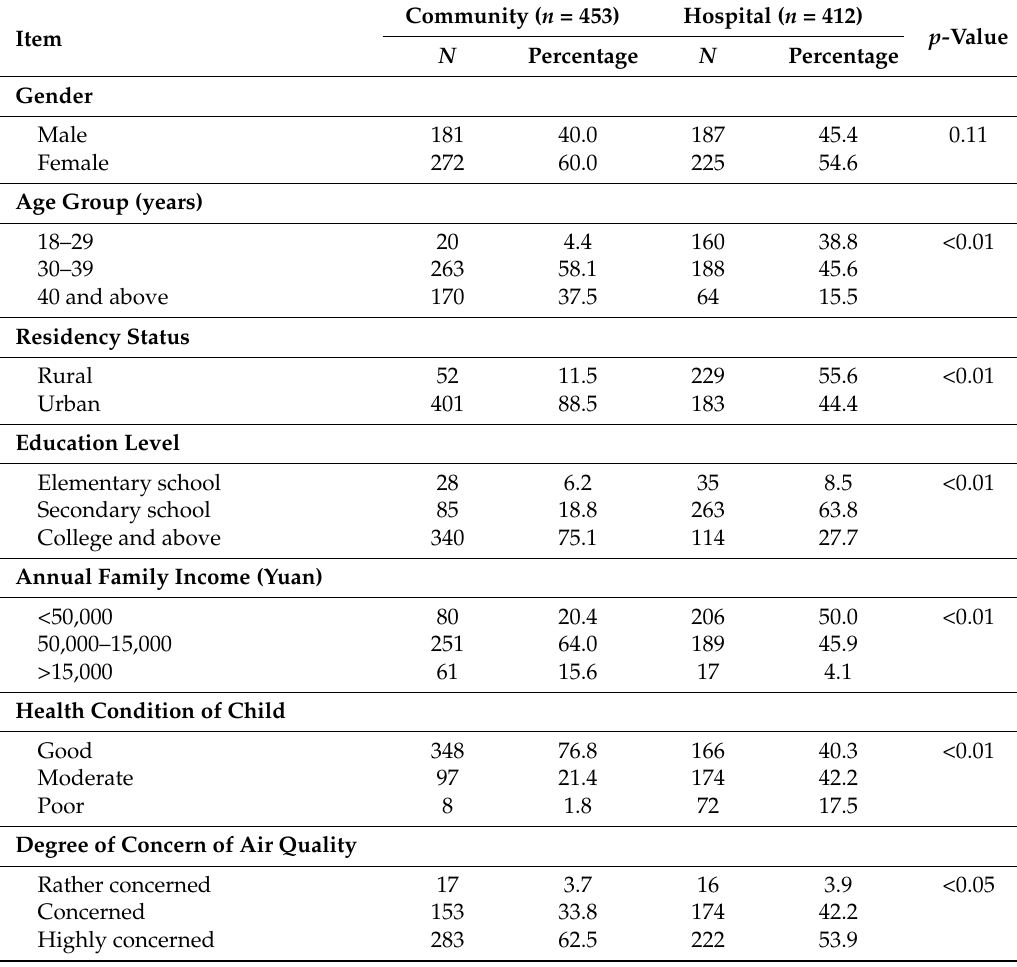
Table 1. General data of the two population